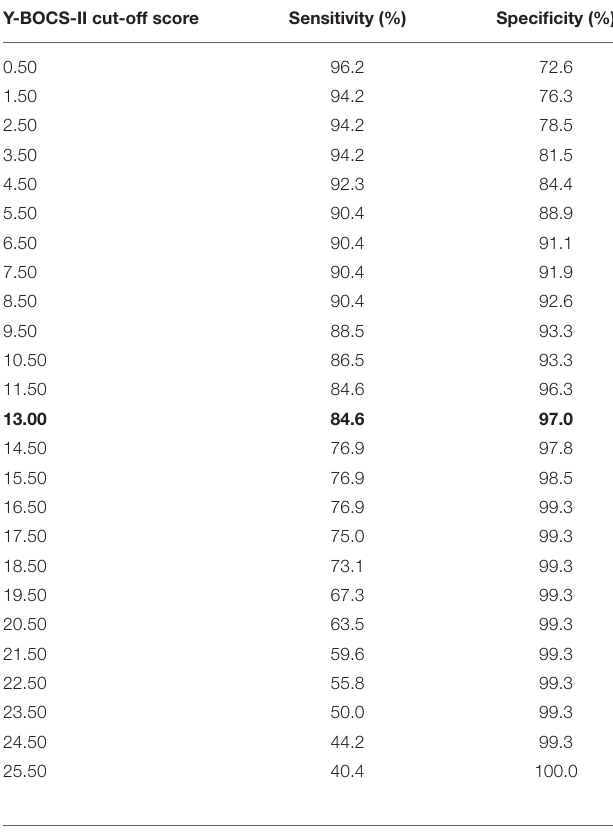
TABLE 4 | Coordinates for the ROC curve of the Y-BOCS-II using all participants. Y-BOCS-II cut-off score Sensitivity (%) Specificity (%) 0.50 96.2